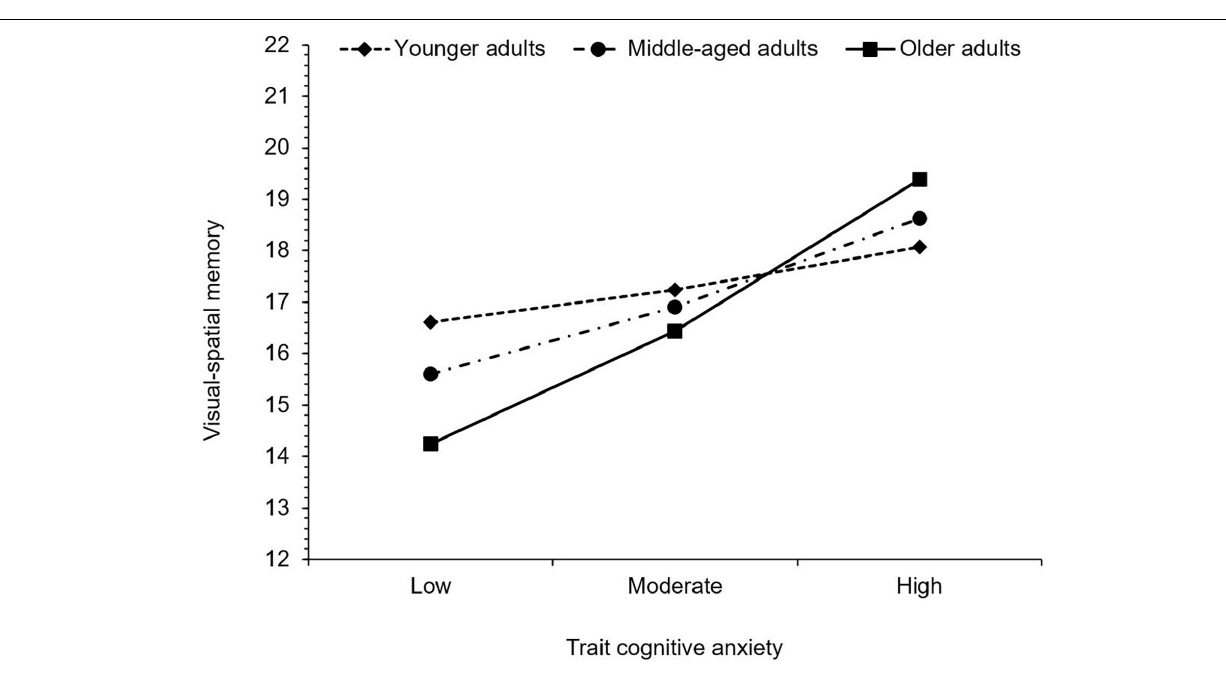
Finally, for visual-spatial memory, trait somatic anxiety was not significantly associated with MASQ scores, and neither was age and the interaction. Only the trait cognitive anxiety covariate